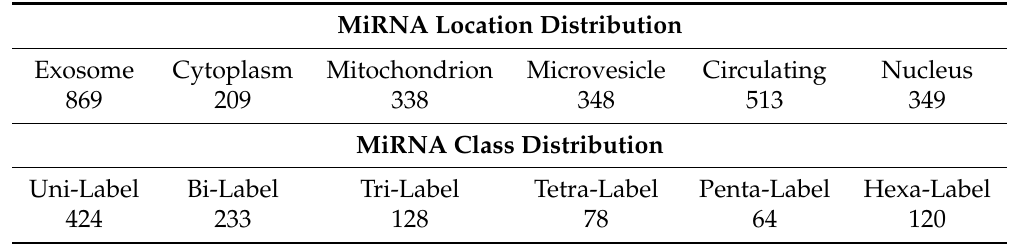
Table 1. Characteristics of the benchmark miRNA subcellular localization dataset